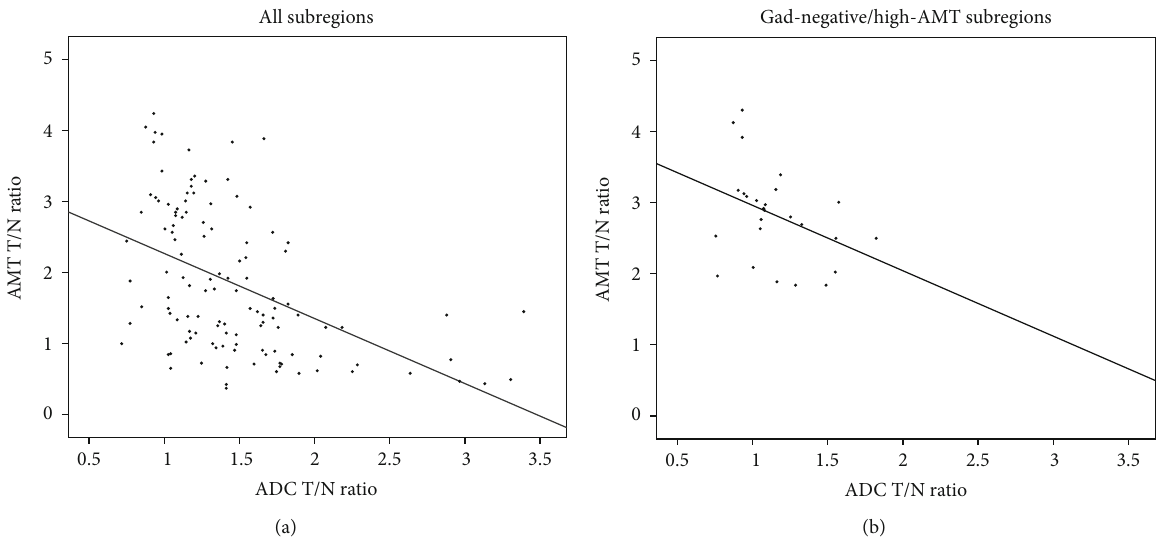
Figure 4: Correlation between AMT uptake and ADC values in glioblastoma subregions. (a) Negative correlation in the whole set of tumor subregions ( N = 115 , including tumor regions with both high and low AMT uptakes; Spearman ’ s rho ½ r (cid:2) = − 0 : 52 , P < 0 : 0001 ). (b) A similar trend was detected in noncontrast-enhancing/high-AMT tumor subregions, consistent with tumor-in fi ltrated brain ( N = 25 , r = − 0 : 40 , P = 0 : 05 ). Reproduced with permission from Figure 3 of John et al.